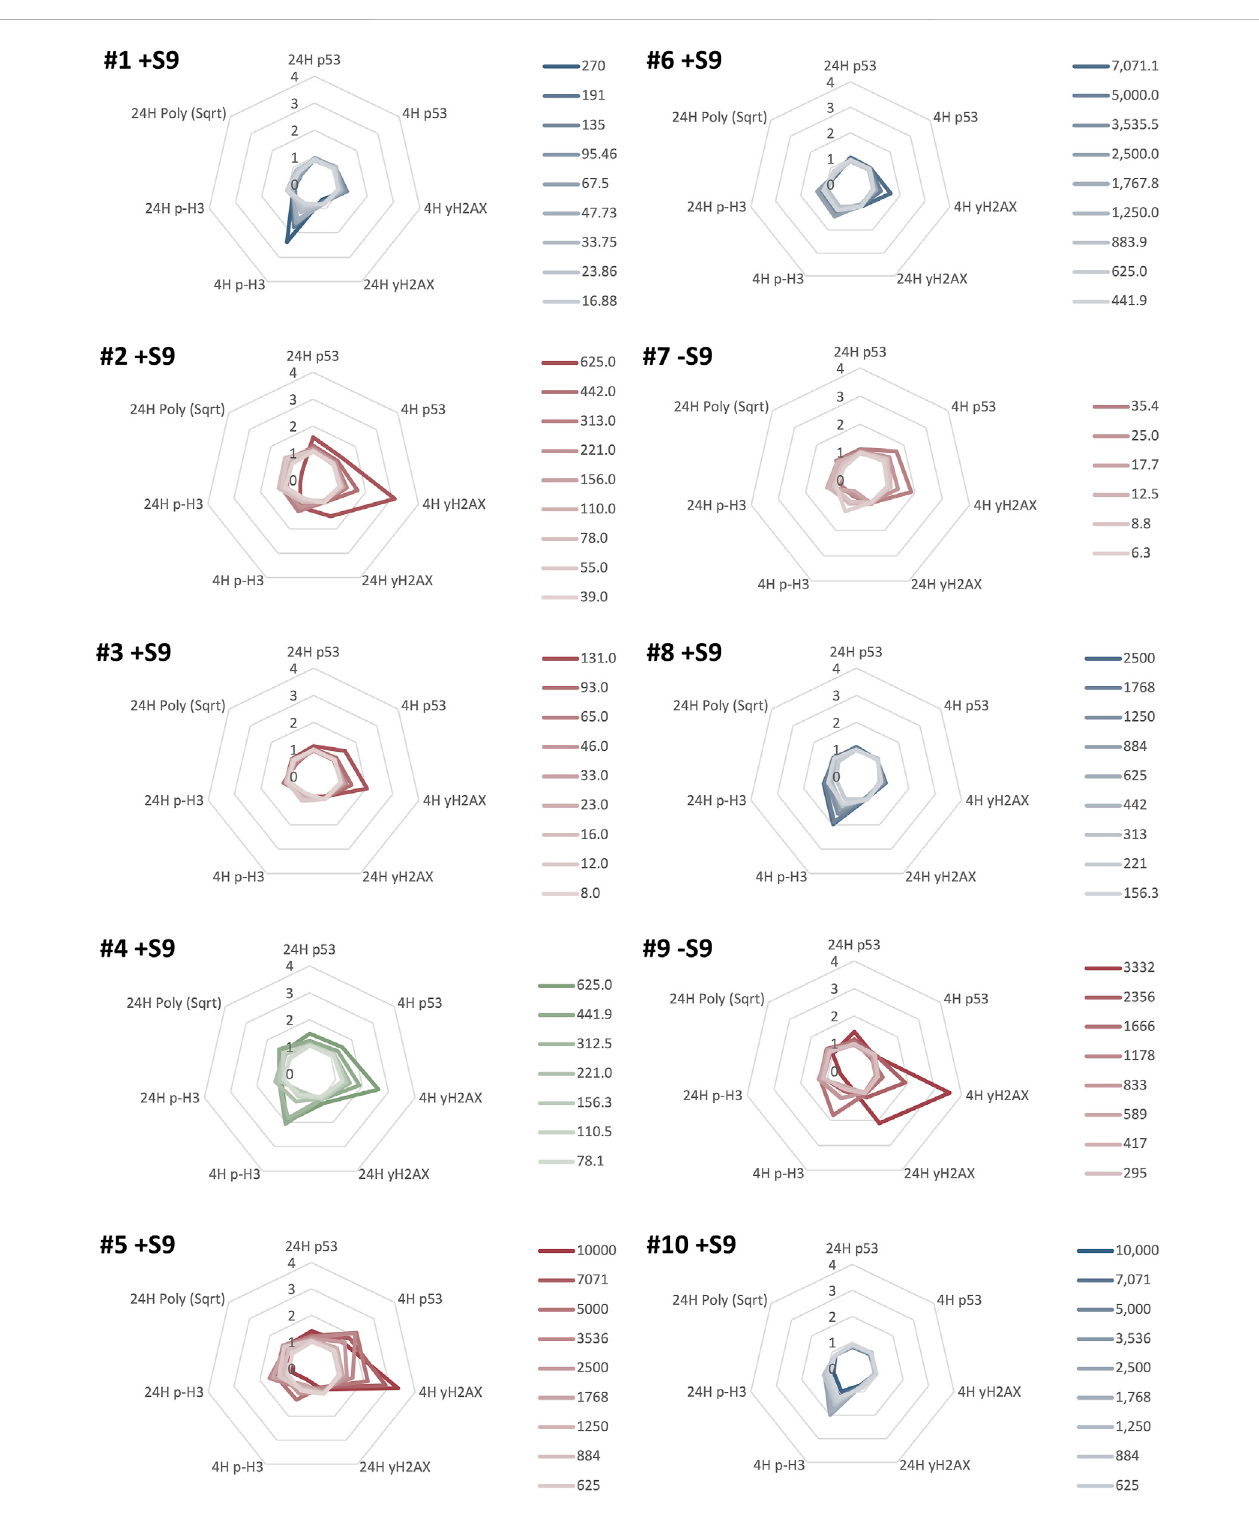
FIGURE 3 MultiFlow ® DNA Damage assay classi fi cation results for ten NSACB data-poor substances (#1 – 10). Each radar plot shows the seven biomarkers predicting the predominant mode of action (MoA) for each chemical. Clastogen MoA biomarkers are on the right of each radar plot: 4H p53, 4H ɣ H2AX, 24H p53, and 24H ɣ H2AX. Aneugen MoA biomarkers are on the left of each radar plot: 4H p-H3, 24H p-H3, 24H Polyploidy, and 24H p53. The biomarker data are expressed as a fold-increase over the mean vehicle control for each non-cytotoxic concentration ( > 20% viability) represented by lines with different colour intensities (as shown in the legend). The line colour in each plot represents the classi fi cation call: clastogens are red, non-genotoxicants are blue, and pan-genotoxicants are green. Chemicals meeting or exceeding the Global Evaluation Factors (GEFs) in at least one concentration in two MoA-speci fi c biomarkers were classi fi ed as aneugenic or clastogenic, or classi fi ed as pan-genotoxic if both the aneugen and clastogen criteria were met. For comparison, the S9 condition presented for each compound is as denoted in Figures 1, 2. Additional results can be found in Supplementary Figure